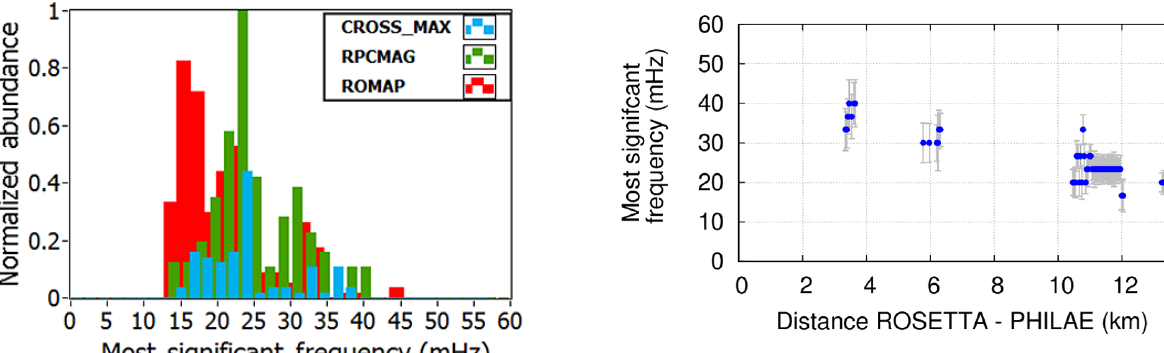
Figure 7. Normalized histograms (using 32 bins) of the most prominent frequencies for measurements by RPCMAG (green) and ROMAP (red). The flywheel signature of PHILAE at ∼ 15mHz can clearly be identified. The blue histogram reflects the distribution of the frequencies at which the maximum cross power spectral density of both instrument datasets occurs.